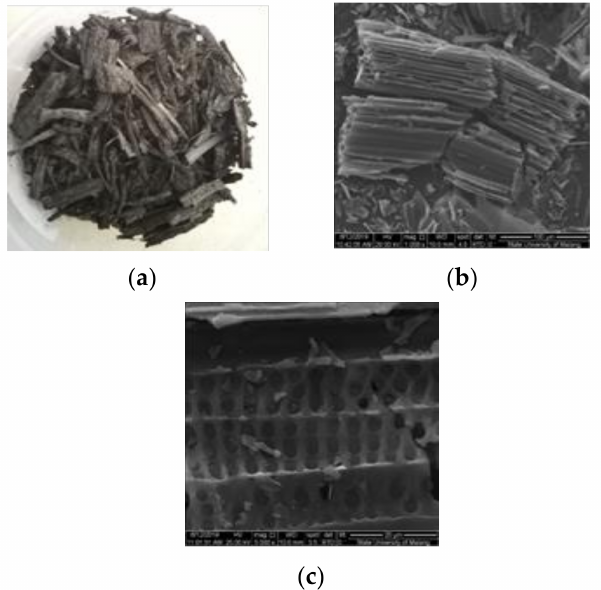
Figure 3. The optical image of carbonized bagasse ( a ), and SEM images of carbonized bagasse at different magnification: ( b ) 1000 × and ( c ) 5000 ×